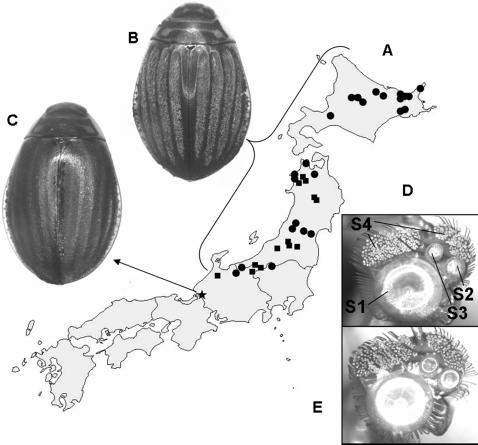
A possible example of recent allopatric speciation driven by sexual conflict [3].A: The distribution of A. japonicus and A. kishii in Japan [31]. • = specimens examined and ▪ = literature records of A. japonicus, ★ = A. kishii. B: ♀ of A. japonicus. C: ♀ of A. kishii. D: ♂ front foot of A. kishii indicating the labelling of suction cups S1–S4. E: ♂ frontfoot of A. japonicus. The sibling species pair A.kishii and A. japonicus are endemic to Japan, with A. kishii occurring in a single mountain lake in Fukui prefecture, just south of A. japonicus range. They differ morphologically only in secondary sexual characters involved in the arms race, in particular the loss in A. kishii of setose furrows in the female.